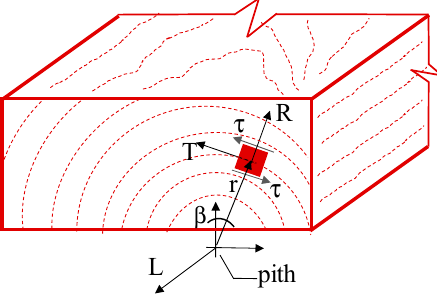
Figure 2. Anatomic directions and rolling shear tangential stresses.